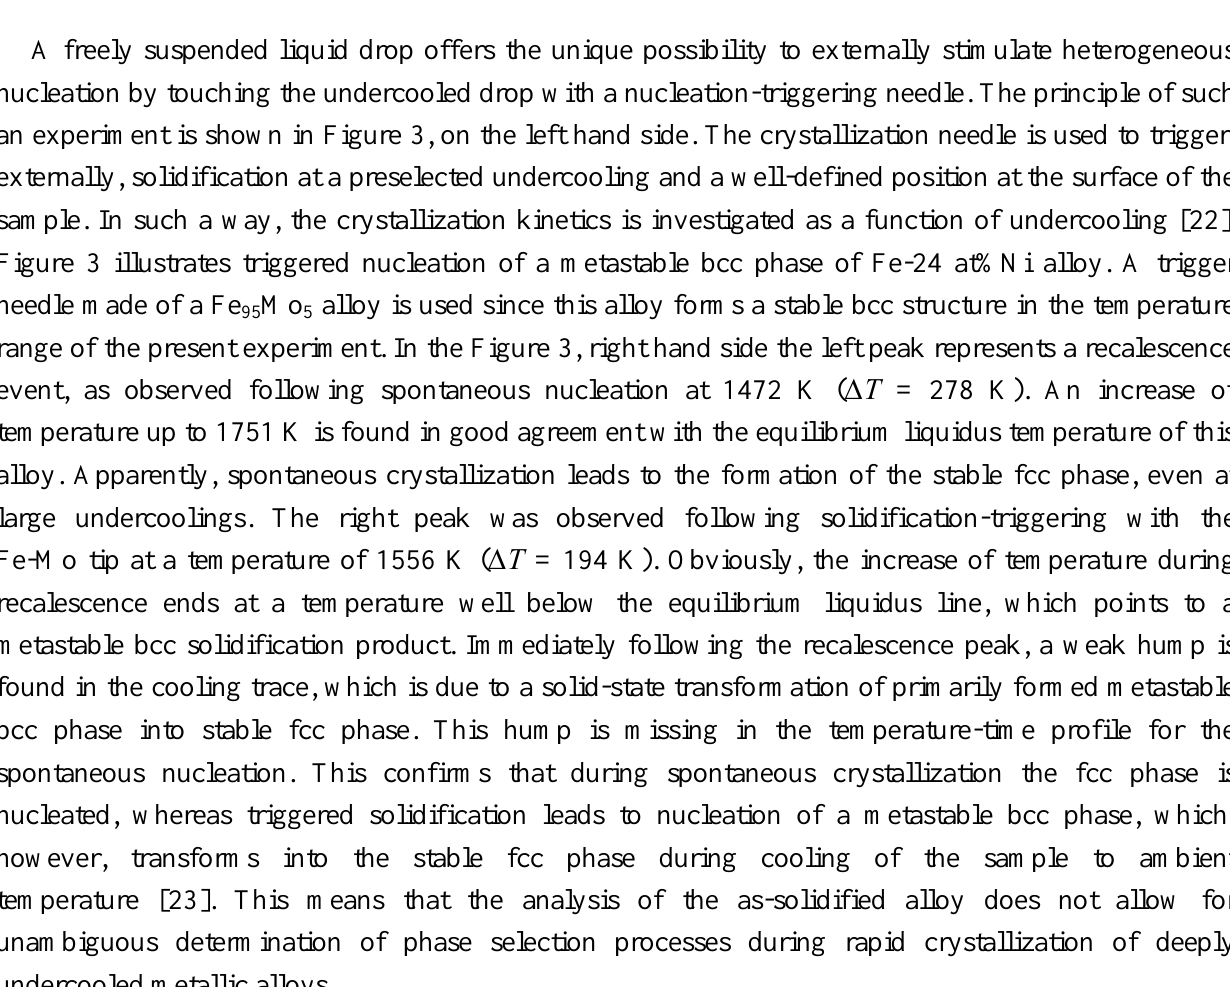
Figure 3. ( Left ) Principle of nucleation triggering of a metastable bcc phase in Fe alloy by using a nucleation trigger made of Fe temperature-time profiles obtained during solidification of undercooled Fe Spontaneous crystallization of stable fcc phase (γ, blue line), and solidification of a metastable bcc phase upon triggering with the Fe